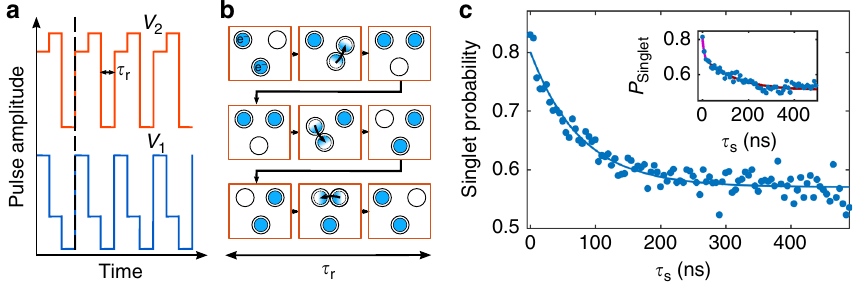
Fig. 3 Coherent spin displacement. a Schematics of the time-dependent sequence applied on gates V 1 and V 2 to perform the electron displacement. N t is the number of loops performed by the electrons and τ r is the duration spent in each charge con fi guration ((1, 1, 0), (0, 1, 1), (1, 0, 1)). Considering the rise time of the pulse generator, the electrons are adiabatically transferred between the dots (see “ Methods ” section). b Schematics of the spatial displacement of the electrons during a single rotation. Most of the displacement is occurring while the electrons are trapped in moving quantum dots. c Singlet probability as a function of the time τ s for the case where the electrons are rotating between separated charge con fi gurations with τ r = 1.7 ns (electron displacement with minimized static phase) and B = 200 mT. The data are fi tted with an exponential decay with a characteristic time τ Decay equal to 78 ns. Inset : Singlet probability as a function of the time τ s for B = 150 mT and τ r = 2.5 ns. The data are fi tted with a two-exponential decay. The solid pink ( red ) line is a fi t of the fast (slow) decay. We notice very similar spin mixing time-evolution with displacement for different tunnel-coupling conditions (see Supplementary Note 6 and Supplementary Fig.